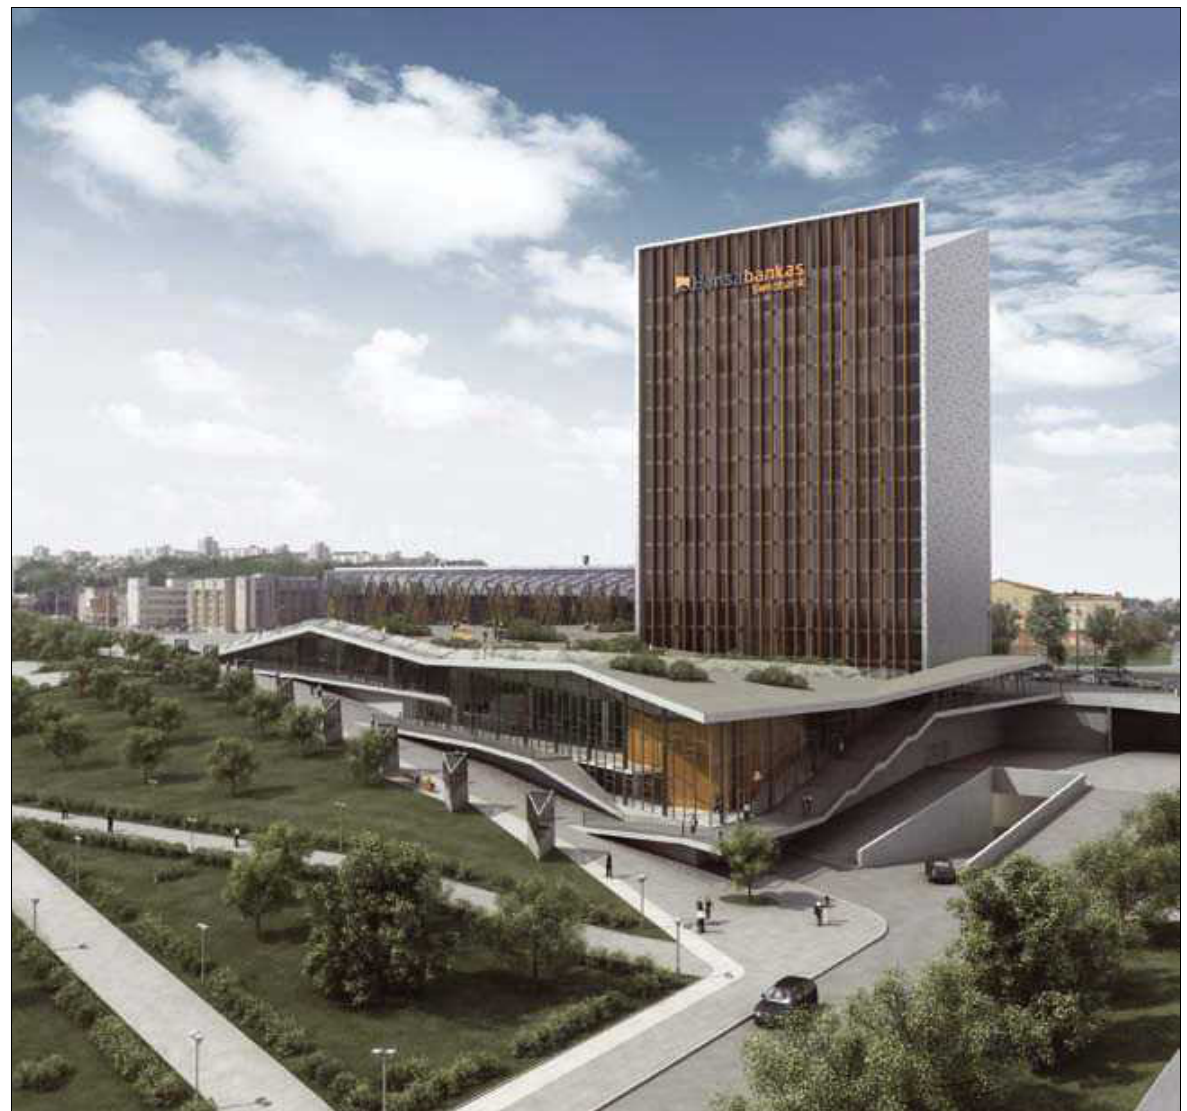
Fig. 19. “hansabankas“ centr­al office in Vilniu­s. a­r­chitects a­. a­mbr­asas, V. a­domonytė, t. eidu­kevičiu­s, D. Malinau­skas.